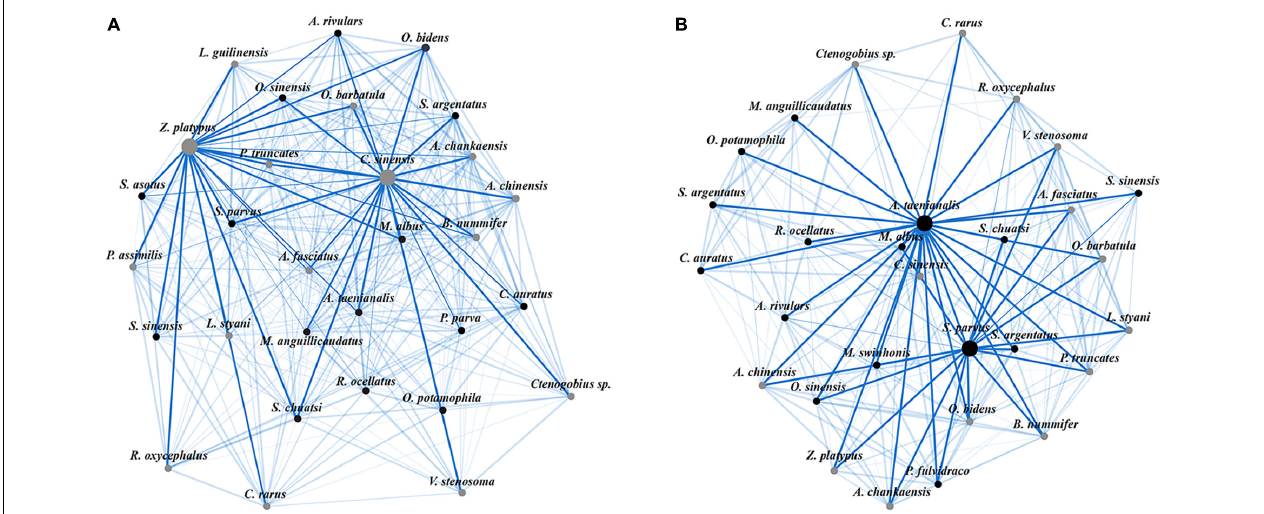
FIGURE 5 | Species interaction networks of stream fish assemblages in the free-flowing segments (A) and impoundments (B) . Each species is represented by a node, and each edge width is proportional to its conditional probability. The native (gray) and native-invasive species (black) are marked differently. For more details about species abbreviations, see Table 1